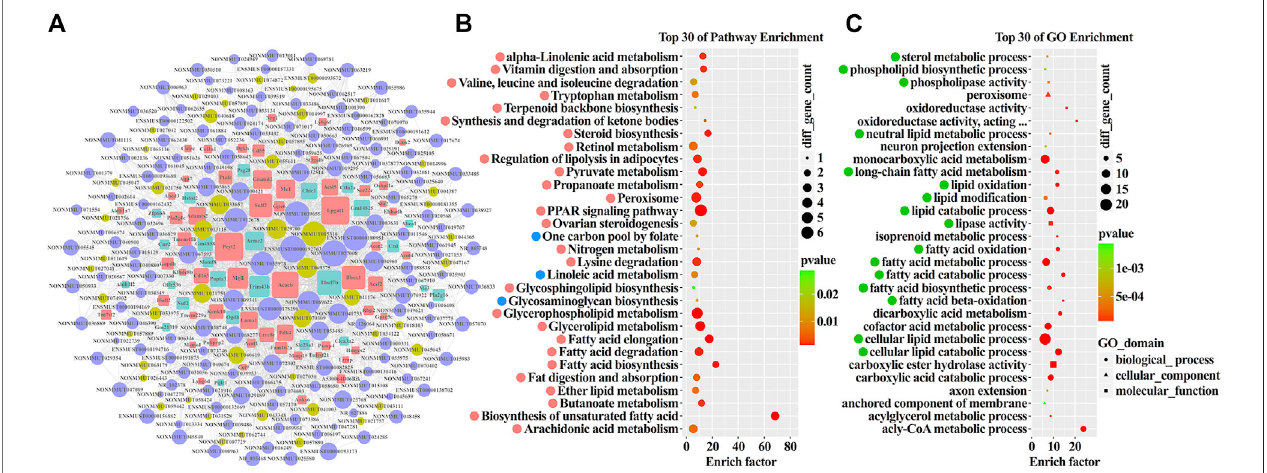
FIGURE 5 | Construction of the lncRNA – mRNA co-expression network and bioinformatic analysis. (A) lncRNA – mRNA co-expression network. Circle nodes with strong yellow and orchid represent up- and downregulated lncRNAs, respectively. Square nodes with soft red and slightly desaturated cyan represent up- and downregulated mRNAs, respectively. (B) Top 30 signi fi cantly enriched pathways ranked with an enrichment score ( p < 0.05). Up- and downregulated pathways are marked with soft red and soft blue, respectively. (C) Top 30 signi fi cantly enriched GO items ( p < 0 .05). The important items are marked with green.